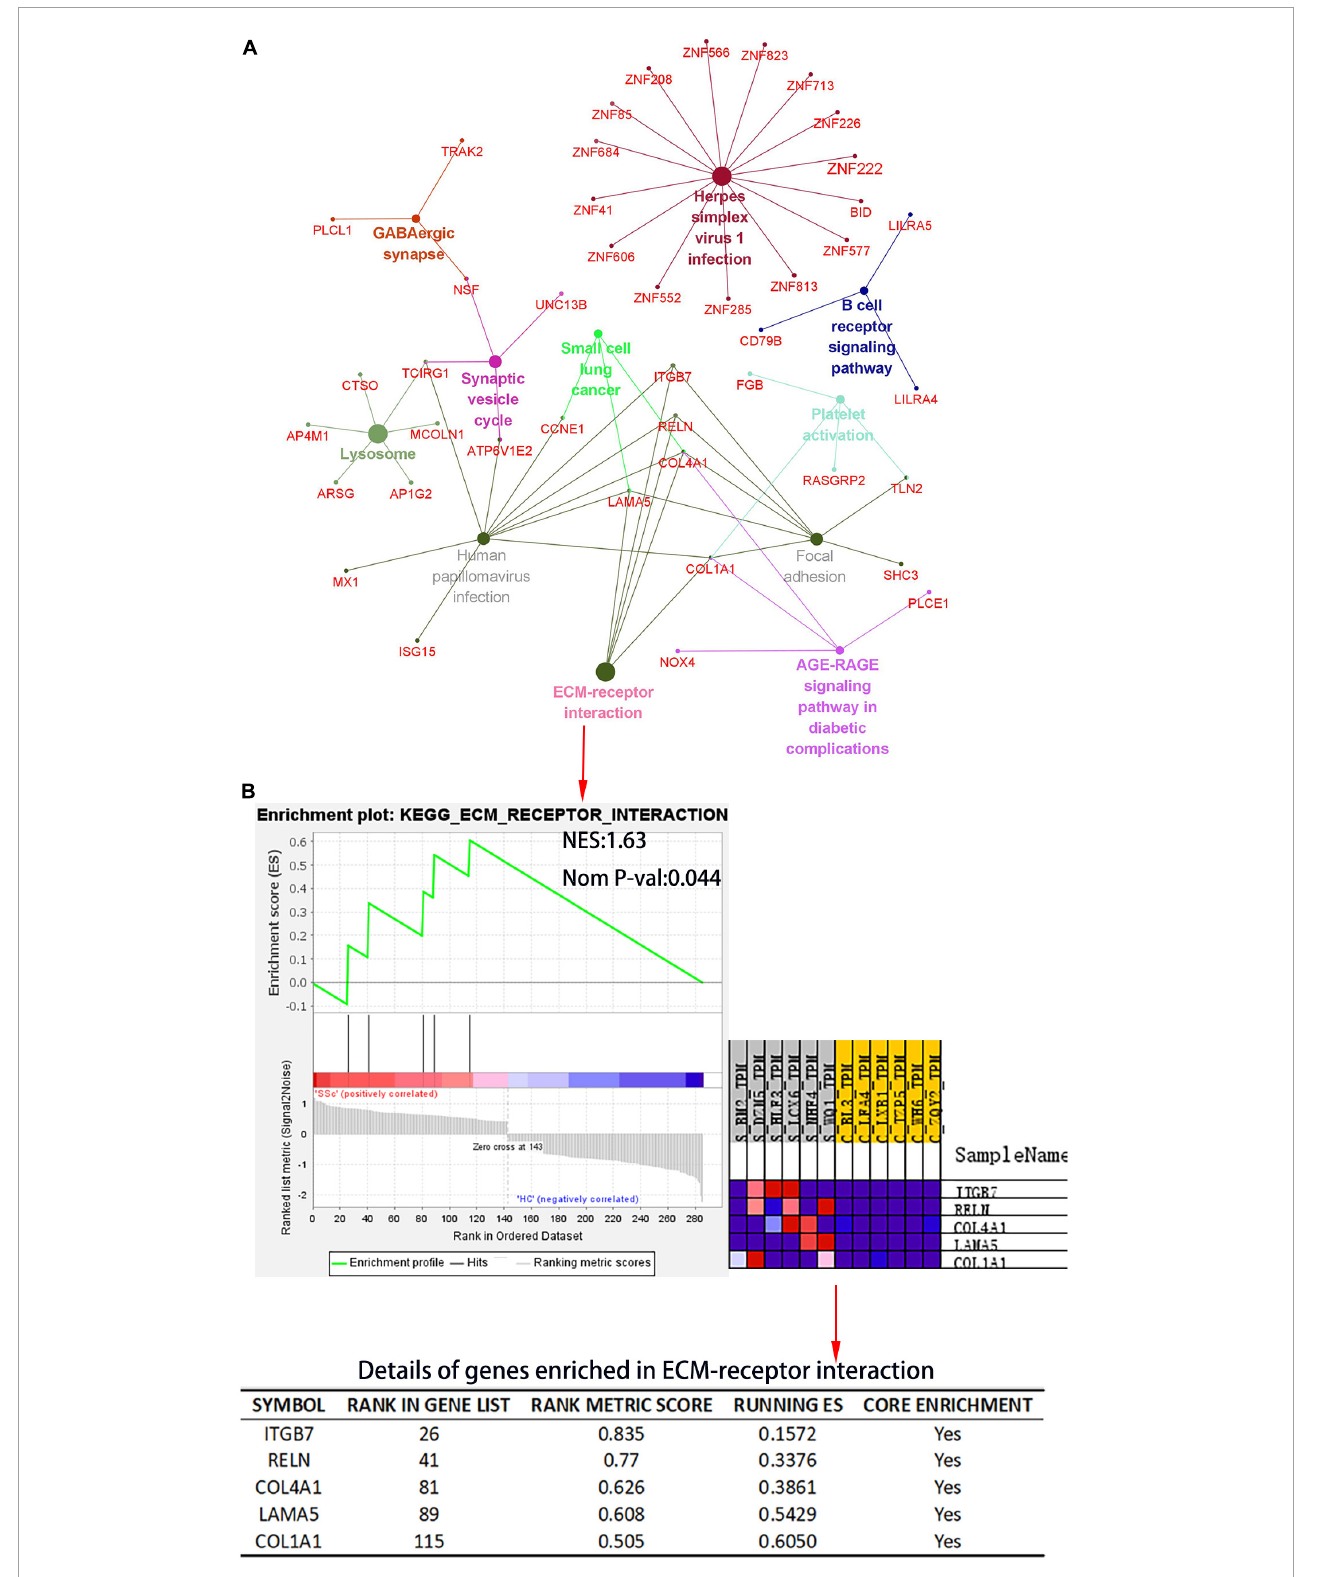
FIGURE5 Kyoto Encyclopedia of Genes and Genomes (KEGG) pathway analysis of the DEmRNA and gene set enrichment analysis (GSEA) of differential gene expression profiles by c2, curated gene sets. (A) KEGG pathway analysis of DEmRNAs. The plug-in ClueGO of Cytoscape was used to map KEGG pathway interactions. Different colors represent different pathways. (B) The c2: KEGG gene set was used to conduct pathway enrichment analysis of DEmRNA profiles. In the table, “RANK IN GENE LIST” represents the position of a gene in the sorted gene set, “RANK METRIC SCORE” is the ranking score of genes, “RUNNING ES” is the dynamic enrichment score (ES) value in the analysis process, and “CORE ENRICHMENT” is the gene that mainly contributes to the ES value. NES, normalized enrichment score; Nom P -val, nominal P